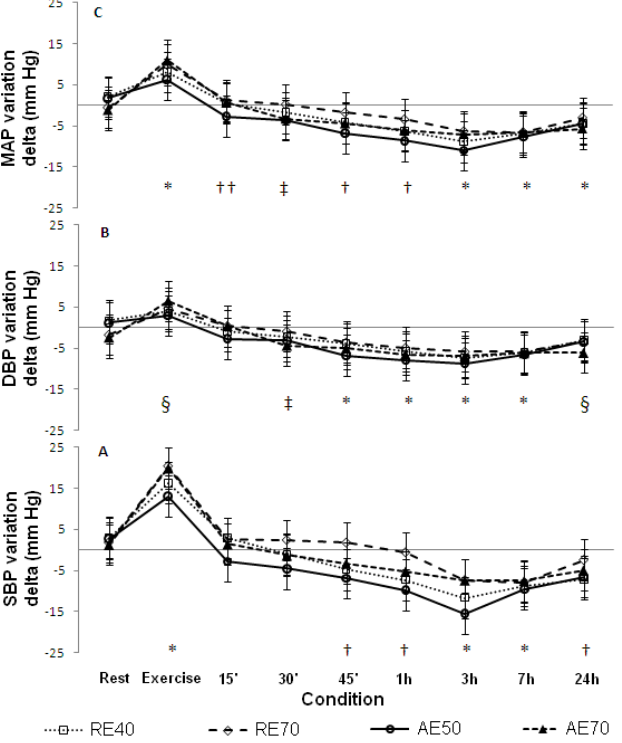
Figure 1. Variation in the changes in (A) the systolic blood pressure, (B) diastolic blood pressure and (C) mean blood pressure for the four experimental sessions compared to the control session over a 24-h period. * p <0.05; significant difference between the control session and the four exercise sessions. † p <0.05; significant difference between the control session and the RE40, AE50 and AE70 sessions. ‡ p <0.05; significant difference between the control session and the AE50 and AE70 sessions. § p <0.05; significant difference between the control session and the AE70 session. †† p <0.05; significant difference between the control session and the AE50 session.